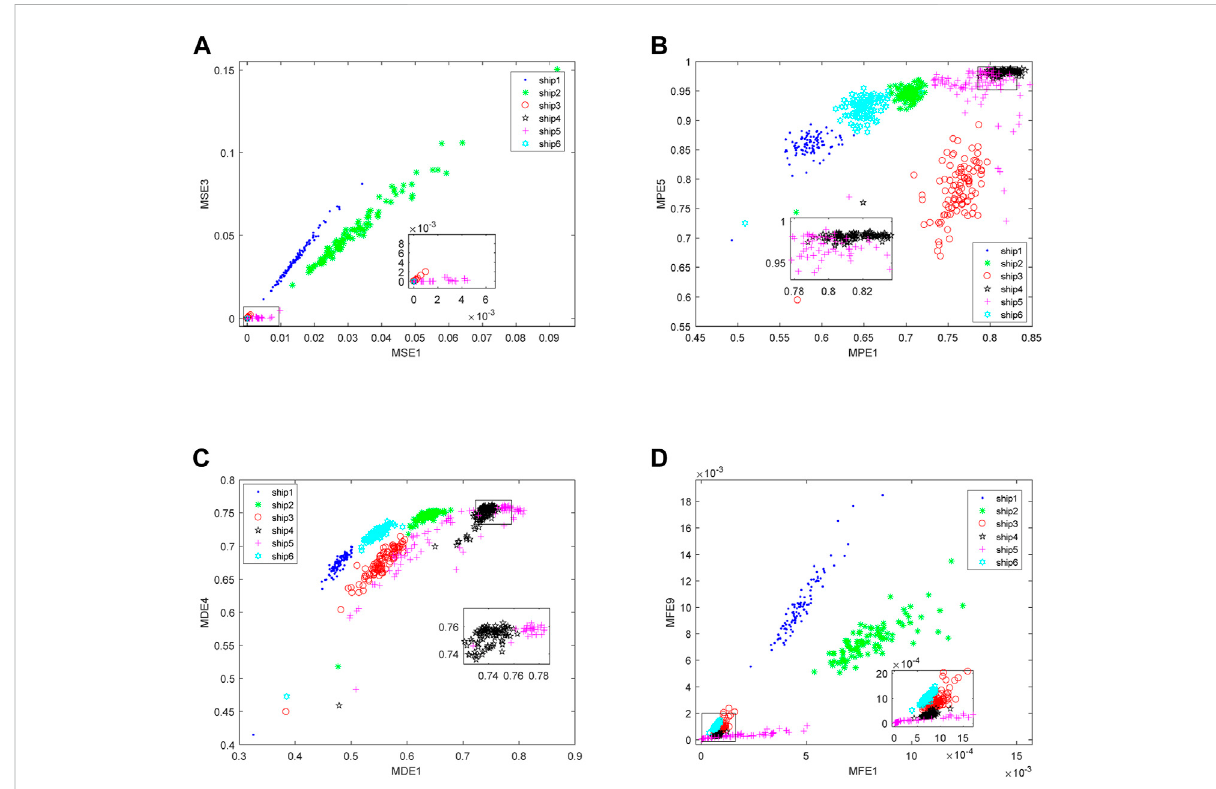
FIGURE 9 Multi-feature distributions correspond to the highest ARR for six SRNs. (A) is MSE, (B) is MPE, (C) is MDE, (D) is MFE.